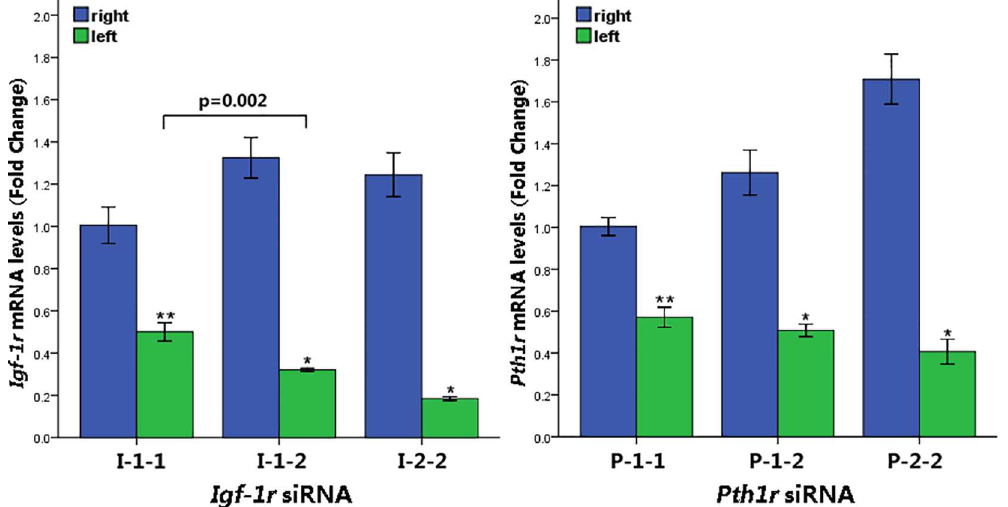
Fig 2. Pth1r and Igf-1r mRNA Expression Levels After siRNA Transfection. The real-time PCR results showed that Pth1r and Igf-1r mRNA expressionlevels were significantly diminished in the left tibia compared with the right tibia (I-1-1 and P-1-1, one injectionfor one week; I-1-2 and P-1-2, one injectionfor two weeks; I-2-2 and P-2-2, two injectionsover two weeks). * p < 0.01, ** p < 0.05vs. the right tibia.